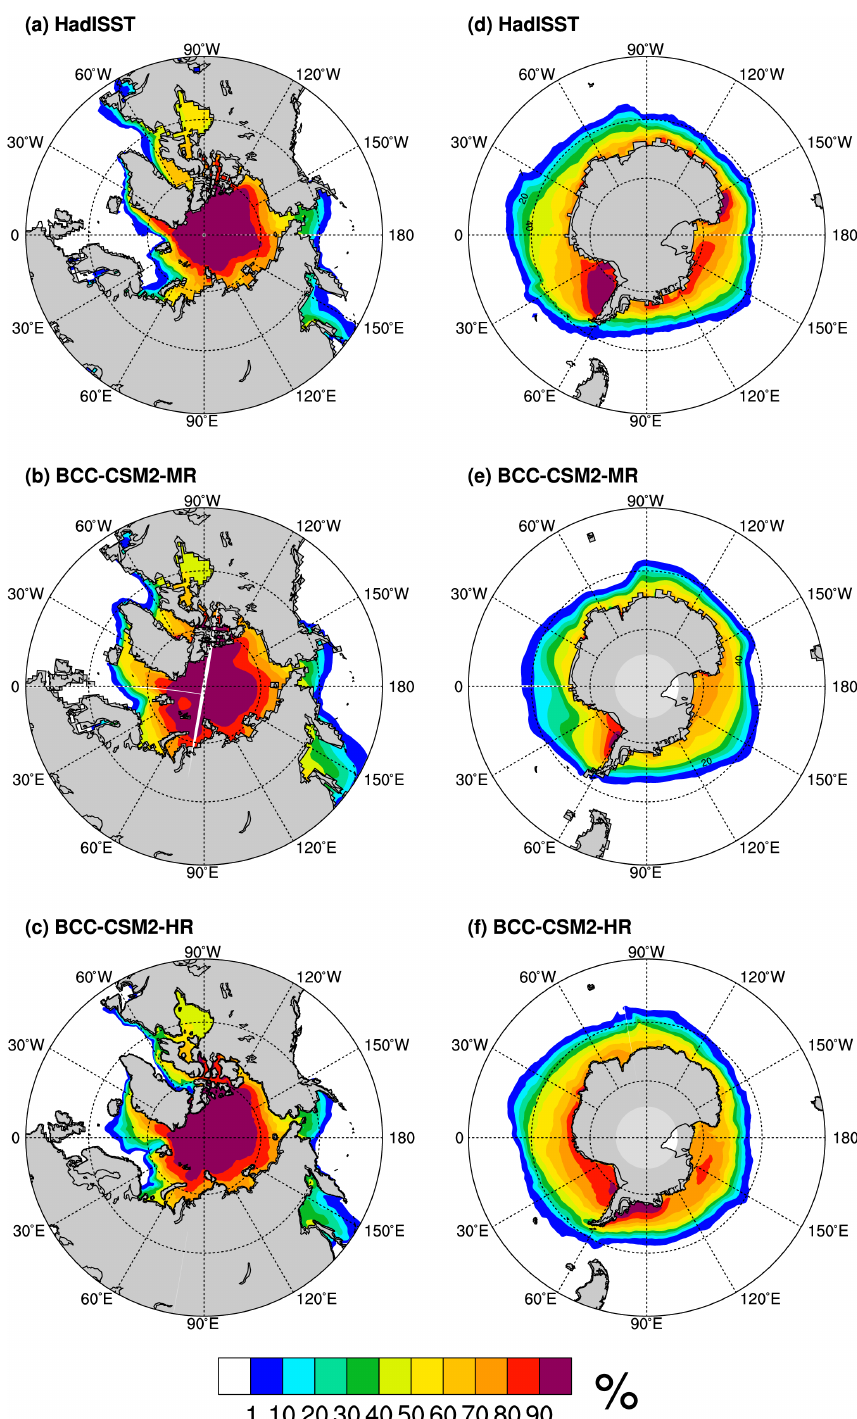
Figure 12. The spatial distribution of annual mean sea-ice concentration from BCC-CSM2-MR and BCC-CSM2-HR in contrast to the observations from the Hadley Centre Sea Ice dataset from 1995 to